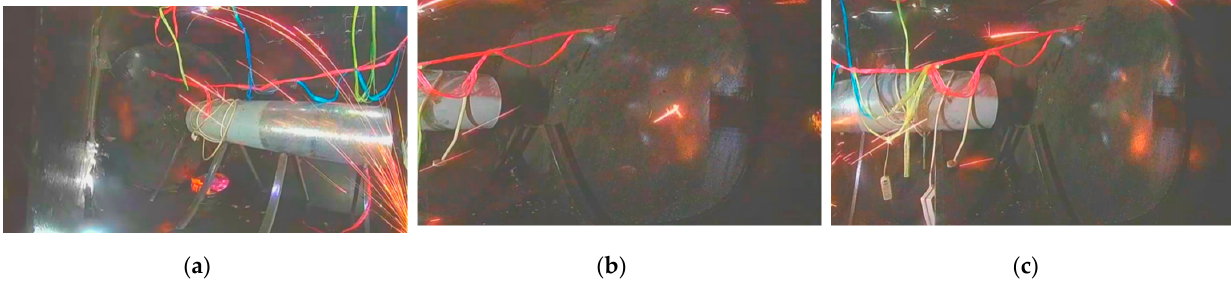
Figure 9. Some of the image data in SAES: ( a ) radiate sparks, flame interference, point light source interference, metal edge and metal reflection interference, and camera jitter interference; ( b ) scattered sparks; and ( c ) scattered sparks capture by a camera in another position.